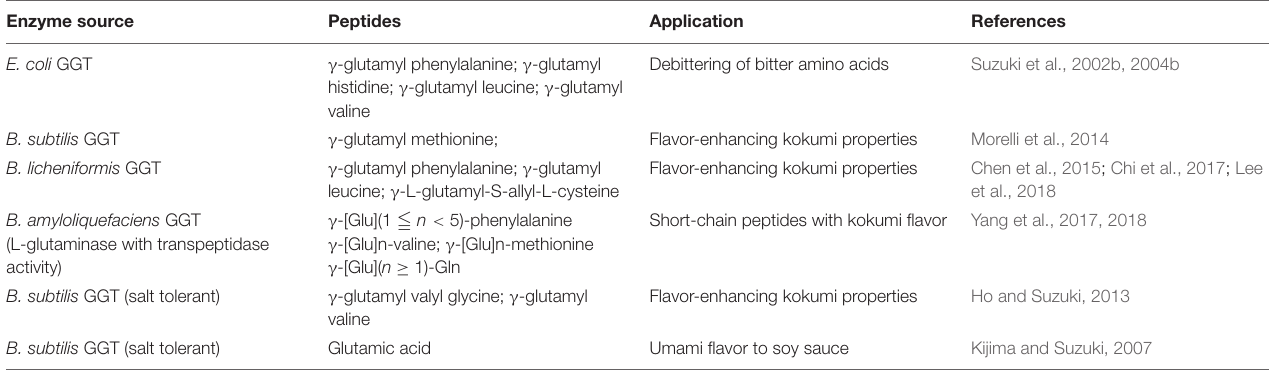
TABLE 6 | List of enzymatically synthesized flavor-enhancing